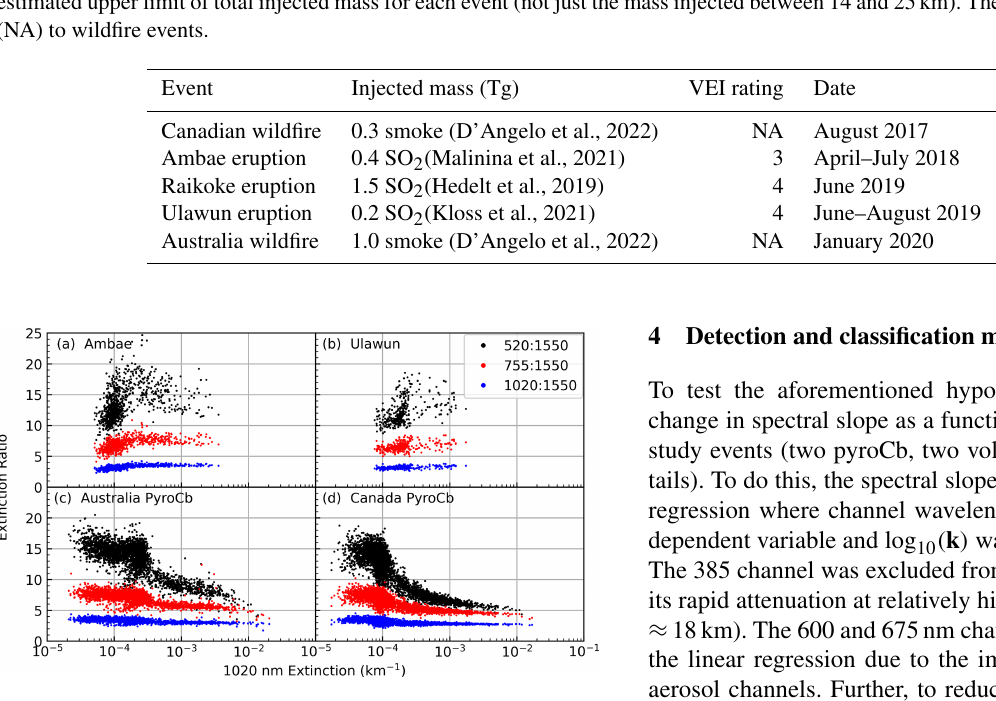
Figure 2. Extinction ratio plots, as a function of k 1020 , for three ratios in the four case-study events. All ratios were referenced to the 1550nm channel, and the data were limited to altitudes between 14 and